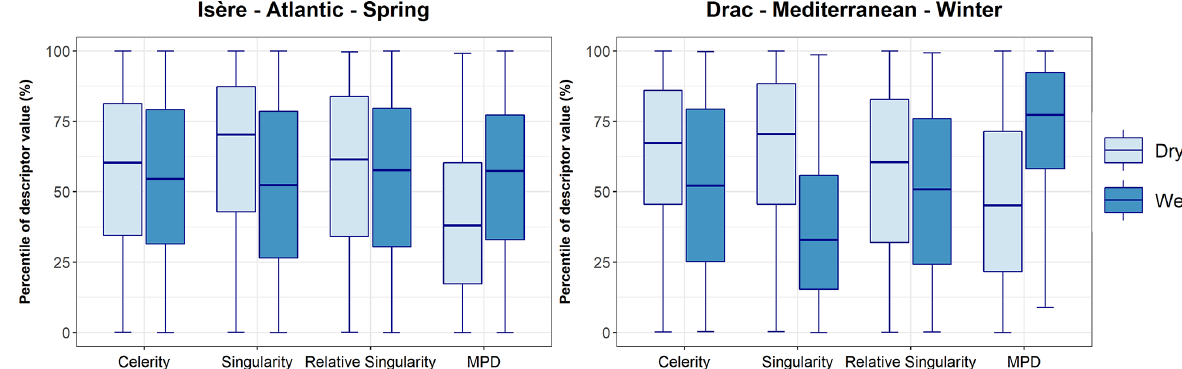
Figure 10. Percentile of descriptor value associated with dry days (light blue) of wet days ( > 1mm, royal blue) for the Isère River catchment in spring under Atlantic circulations (left) and for the Drac River catchment in winter under Mediterranean circulations. Percentiles are computed with respect to the days associated with the given atmospheric influence over the period